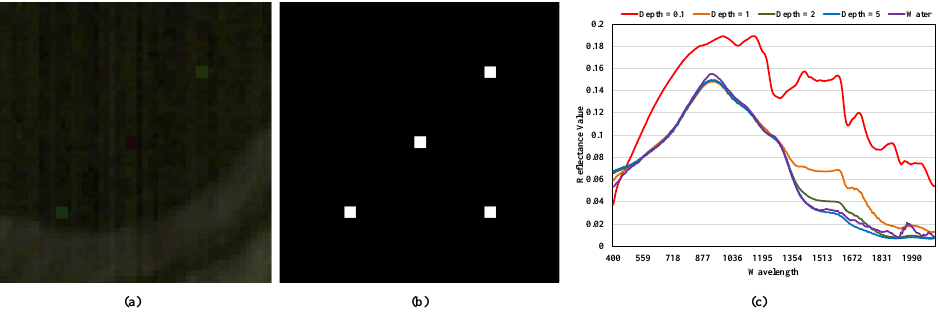
Figure 7. Synthetic data based on sea water for experiment. ( a ) Image scene of sea water; ( b ) distribution of desired targets; and ( c ) spectra of desired targets and main backgrounds.